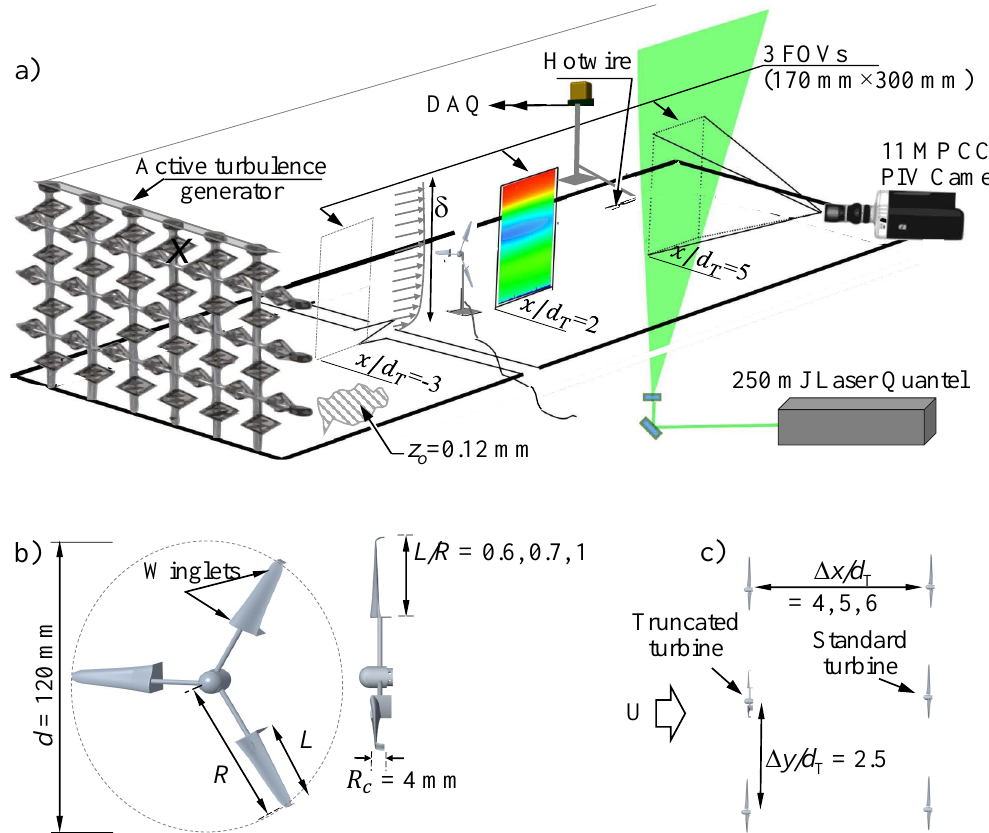
Figure 1. ( a ) Basic schematic of the experimental setup illustrating the PIV locations; ( b ) details of the modified rotors with the lift-producing section restricted to the outer part of the rotor highlighting the winglets at both ends; ( c ) diagram of the 2 × 3 turbine array with a truncated